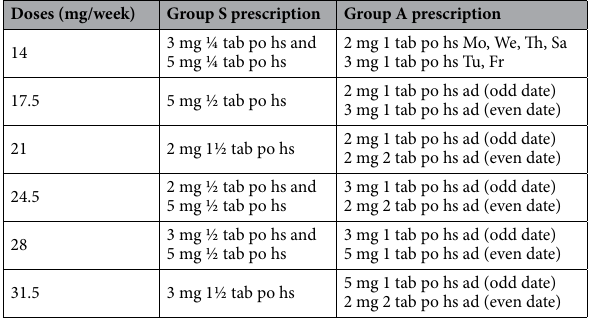
Table 1. Warfarin dosing protocol. Fr Friday, Mo Monday, Sa Saturday, Th Thursday, Tu Tuesday, We